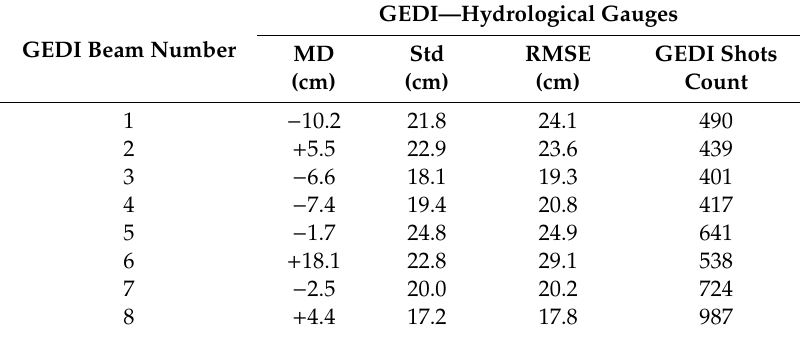
Table 5. Summary statistics for each GEDI beam (Mean MD and standard deviation std) for the difference between GEDI and in-situ elevations using all acquired GEDI waveforms (from all acquisition dates over all lakes).